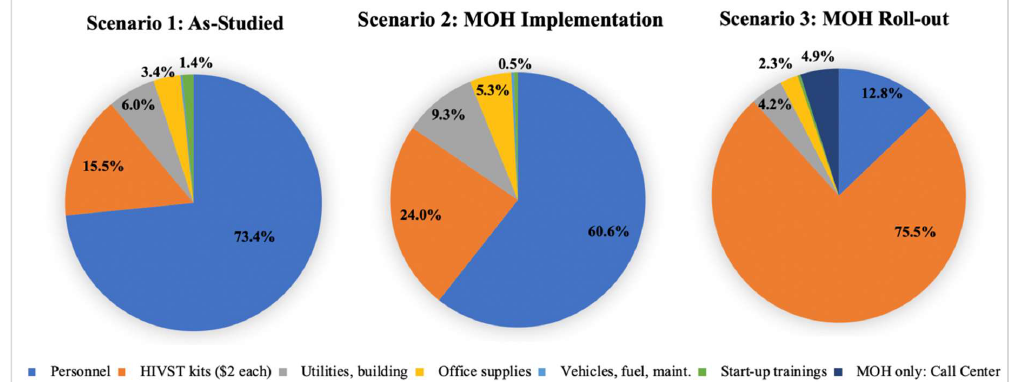
Figure 2. Allocation of HIVST delivery costs per female client by scenario.